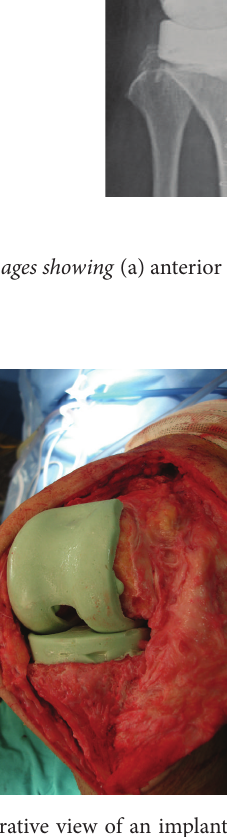
Figure 4: An intraoperative view of an implanted CPLS immedi- ately before revision